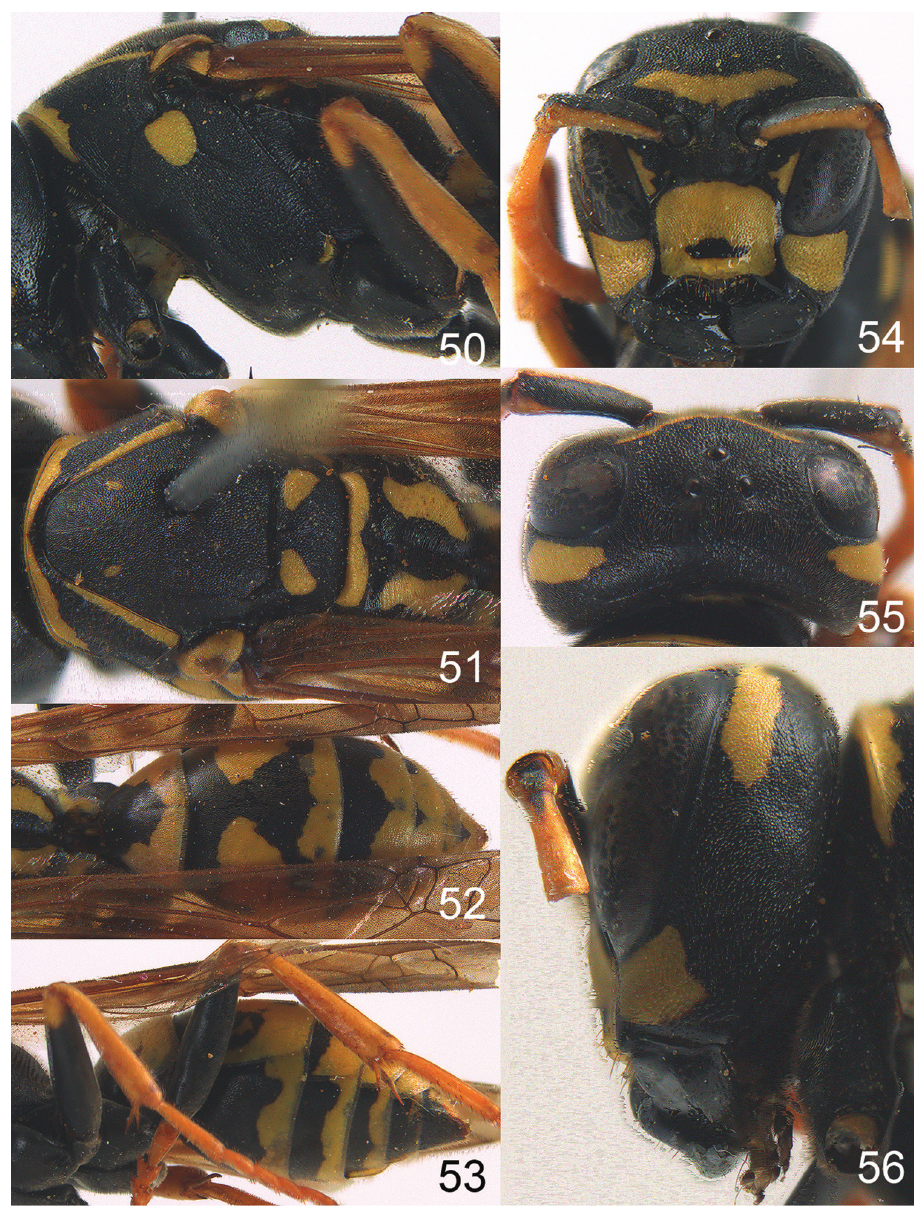
Figures 50–56. Polistes maroccanus sp. n. Holotype female. 50 mesosoma in lateral view, 51 mesosoma in dorsal view 52 metasoma in dorsal view 53 metasoma in ventrolateral view 54 head in frontal view 55 head in dorsal view 56 head in lateral